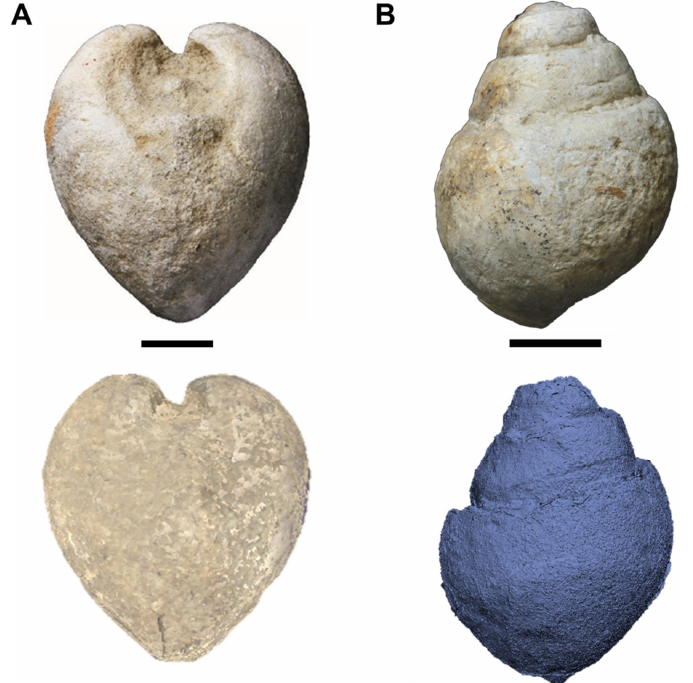
Figure 6. Three-dimensional models of the fossil casts of invertebrate specimens scanned with a small object scanner. ( A ) Granocardium ( Granocardium ) productum bivalve photograph (top view) and 3D model (bottom view). ( B ) Tylostoma torrubiae gastropod photograph (top view), and 3D model with “solid object” option (bottom view). Graphic scales: 1 cm.